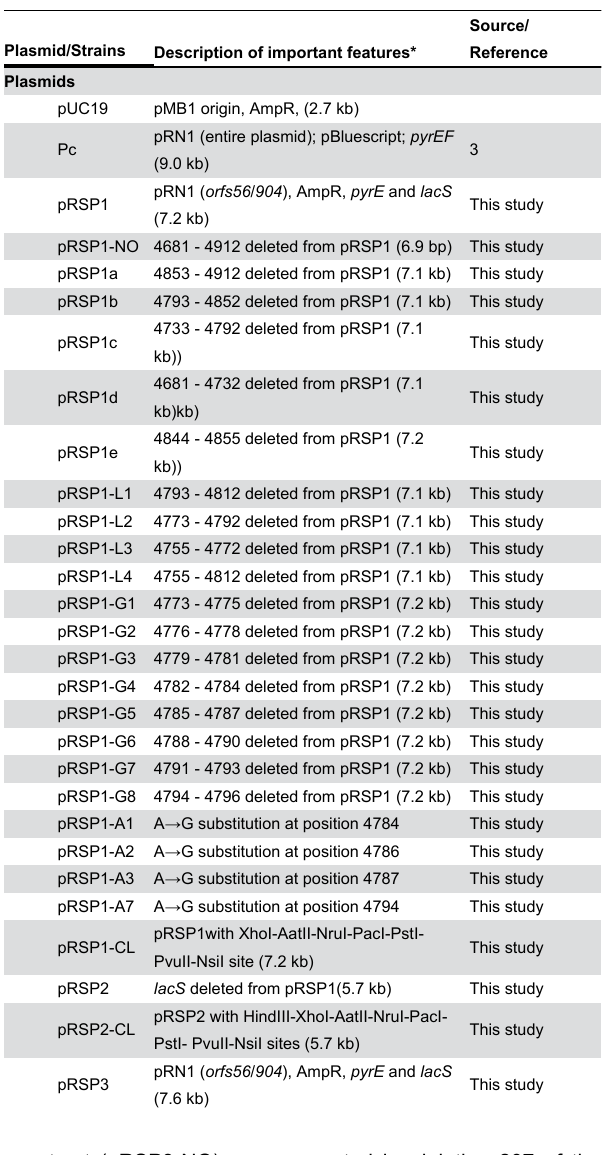
Table 1. Description of plasmids and strains.